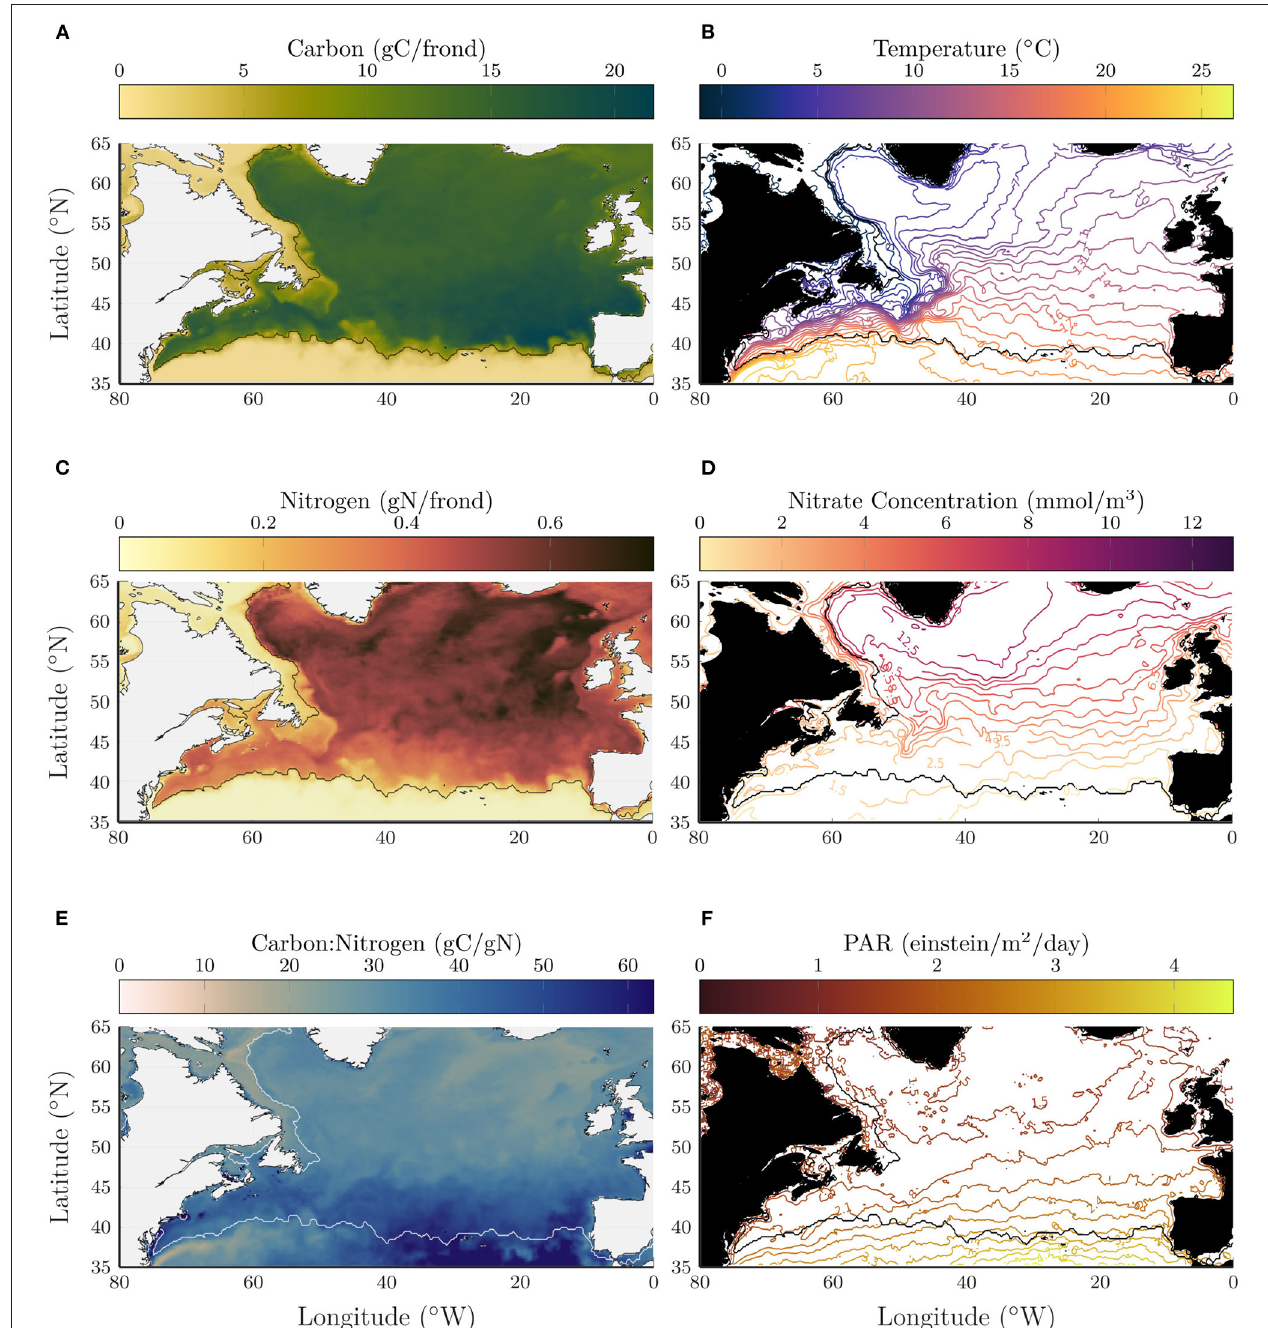
FIGURE 1 | Depth-averaged carbon (A) , nitrogen (B) , and carbon:nitrogen ratio (C) on year day 344 in early November when the total carbon content is maximum in the kelp model. Temperature (D) and nitrate concentration (E) and photosynthetically available radiation (F) that were used as input to the kelp growth model, here shown averaged in time (400 days) and depth (0–75 m) over the kelp deployment. For reference the 5gC/frond contour is shown in black (white in C ), indicating the limits of the region with significant kelp growth.